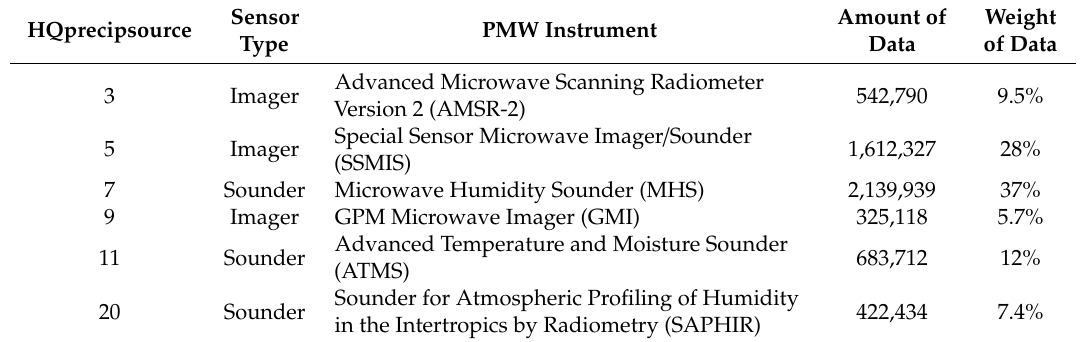
Table 2. List of the passive microwave (PMW) instruments and the data amount in this